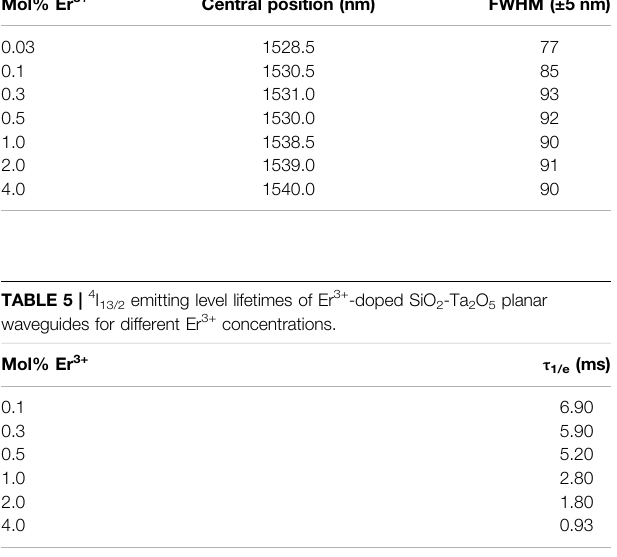
TABLE 4 | Values of central positions and bandwidths of the 4 I 13/2 → 4 I 15/2 Er 3+ transition for Er 3+ -doped SiO 2 -Ta 2 O 5 nanocomposites doped with different Er 3+ concentrations, annealed at 1100 ° C for 8 h.